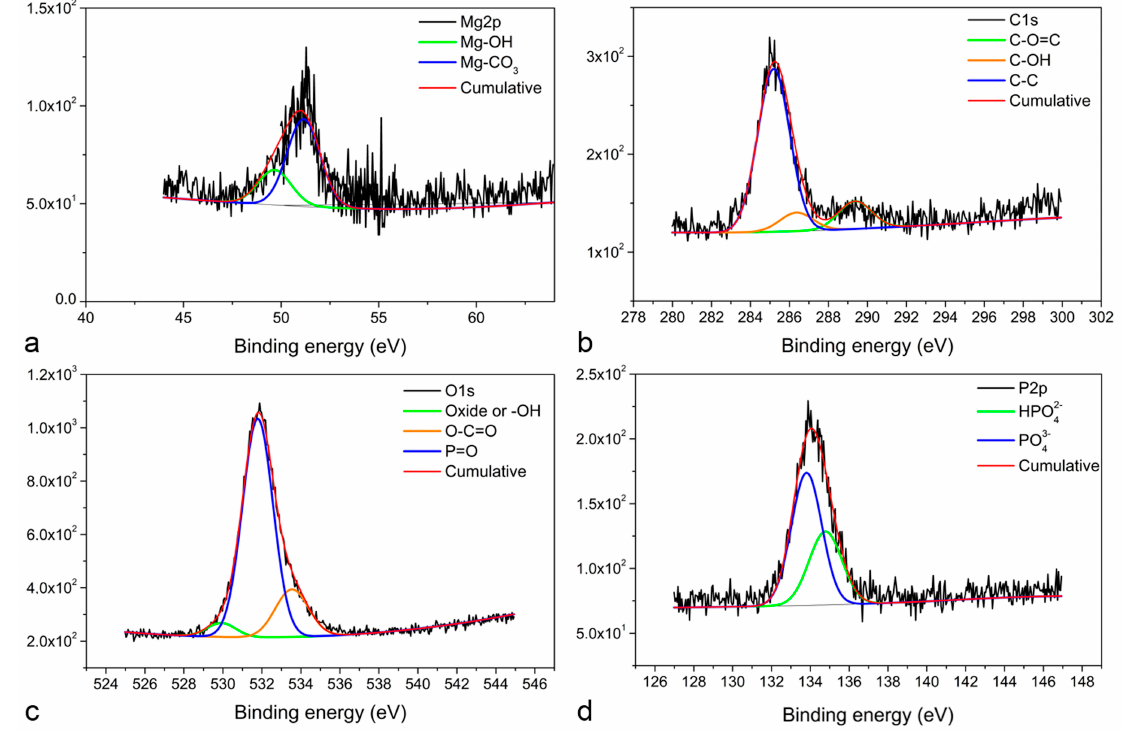
Figure 3. High resolution XPS spectra for pure Mg specimen: ( a ) Mg2p peaks, ( b ) C1s peaks, ( c ) O1s peaks, and ( d ) P2p peaks. Materials 2018 , 11 , x FOR PEER REVIEW